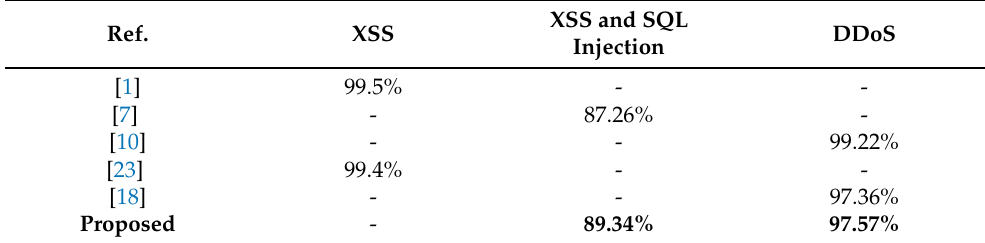
Table 1. Model performance comparison in terms of